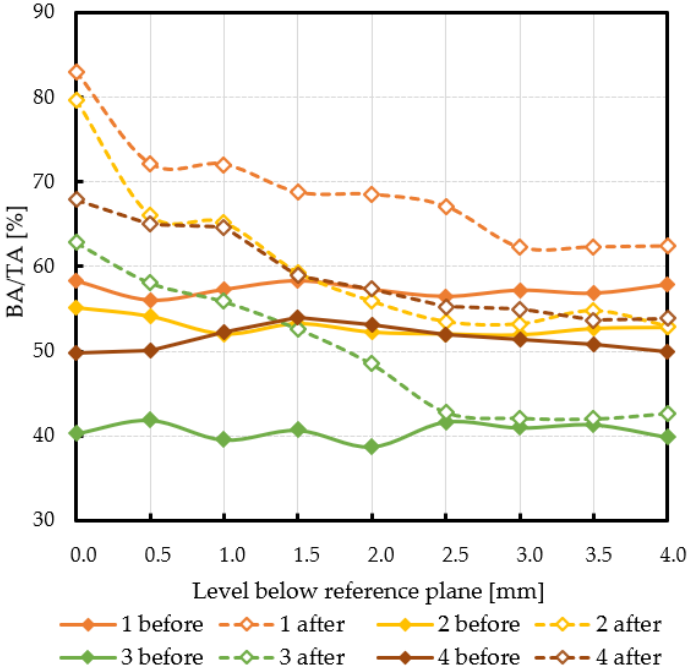
Figure 5. The subchondral trabecular bone relative area (BA/TA, bone area/total area ratio) values in micro-CT analyzed femoral heads’ samples removed during THA from OA patients before and after MSC-Scaffold prototype embedding, on various section levels below the reference plane.